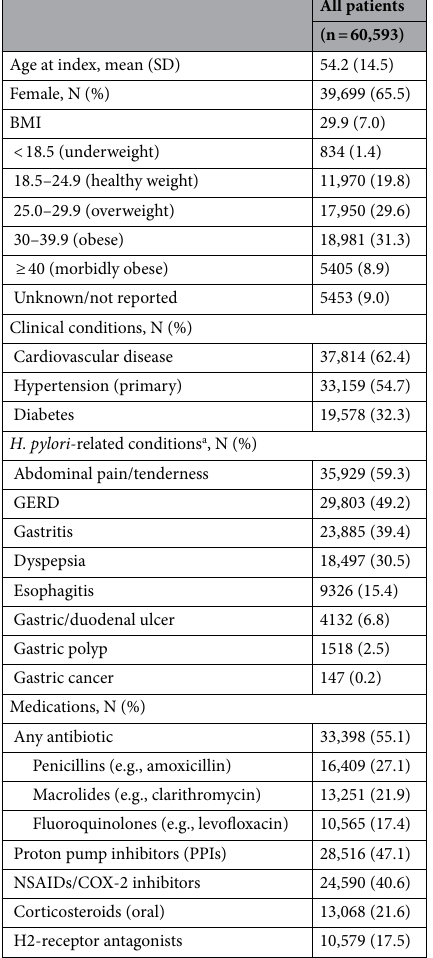
Table 1. Characteristics of patients with newly diagnosed Helicobacter pylori infection during the 12-month baseline period. COX, cyclooxygenase-2; GERD, gastroesophageal reflux disease; H2, histamine type 2; NSAID, Non-steroidal anti-inflammatory drug. a Presence of conditions determined by diagnosis codes and did not require having a prior claim for diagnostic testing such as